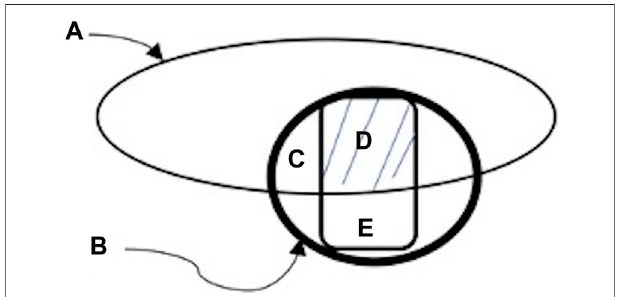
FIGURE 10 | The rectangle introduced with respect to Figure 9 represents the trustworthy agents with respect to τ s